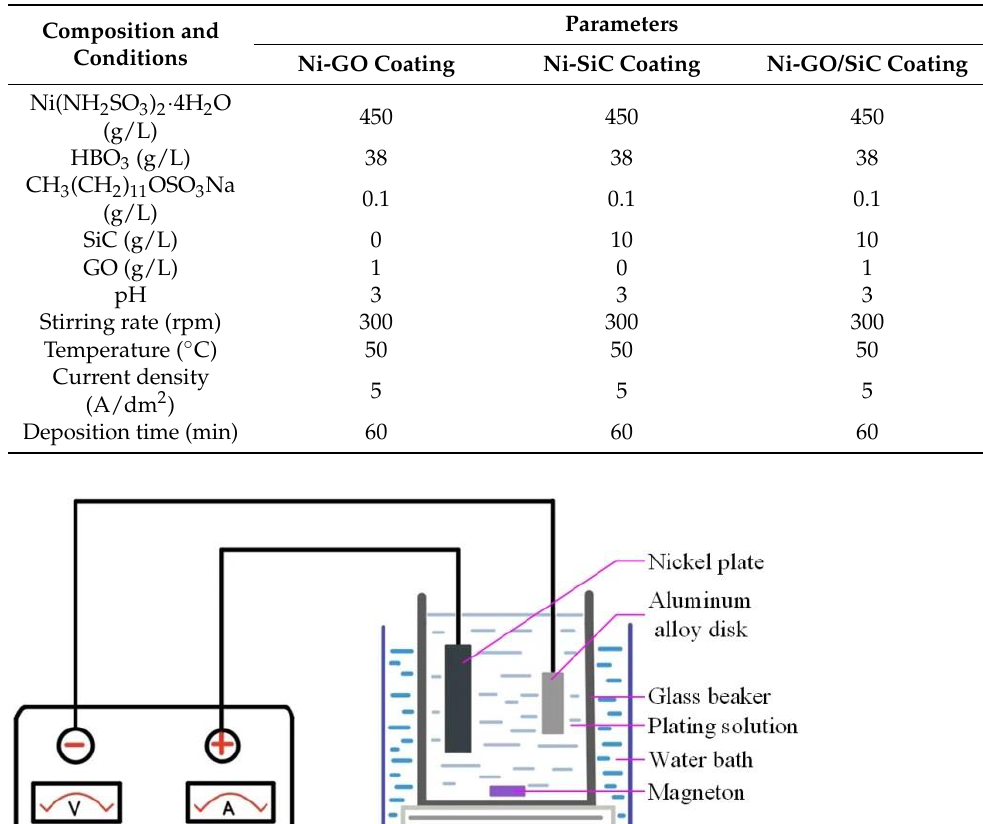
Table 2. Composition of plating solution and operating conditions.